Question: Author a descriptive caption for the visualization shown.
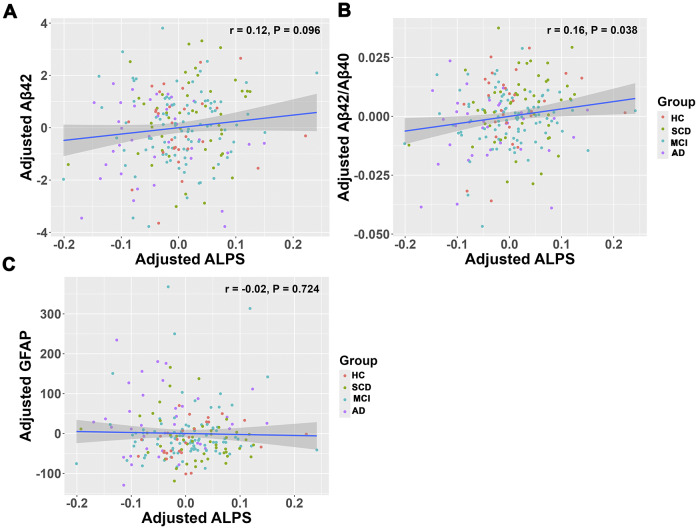
Answer: Association between ALPS and plasma biomarkers. After regressing for gender, age, education level, and APOE4 carrier status, there was no significant correlation between ALPS and Aβ42 ( r = 0.12, P = 0.096); ALPS was positively correlated with Aβ42/Aβ40 levels ( r = 0.16, P = 0.038). There was no significant correlation between ALPS and GFAP ( r = −0.02, P = 0.724). Note: ALPS, ‘Analysis of diffusion tensor imaging along the perivascular space’; HC, ‘Healthy Controls’; SCD, ‘Subjective Cognitive Decline’; MCI, ‘Mild Cognitive Impairment’; AD, ‘Alzheimer’s Disease’; MMSE, ‘Mini-Mental State Examination’. Figure 3. long description.